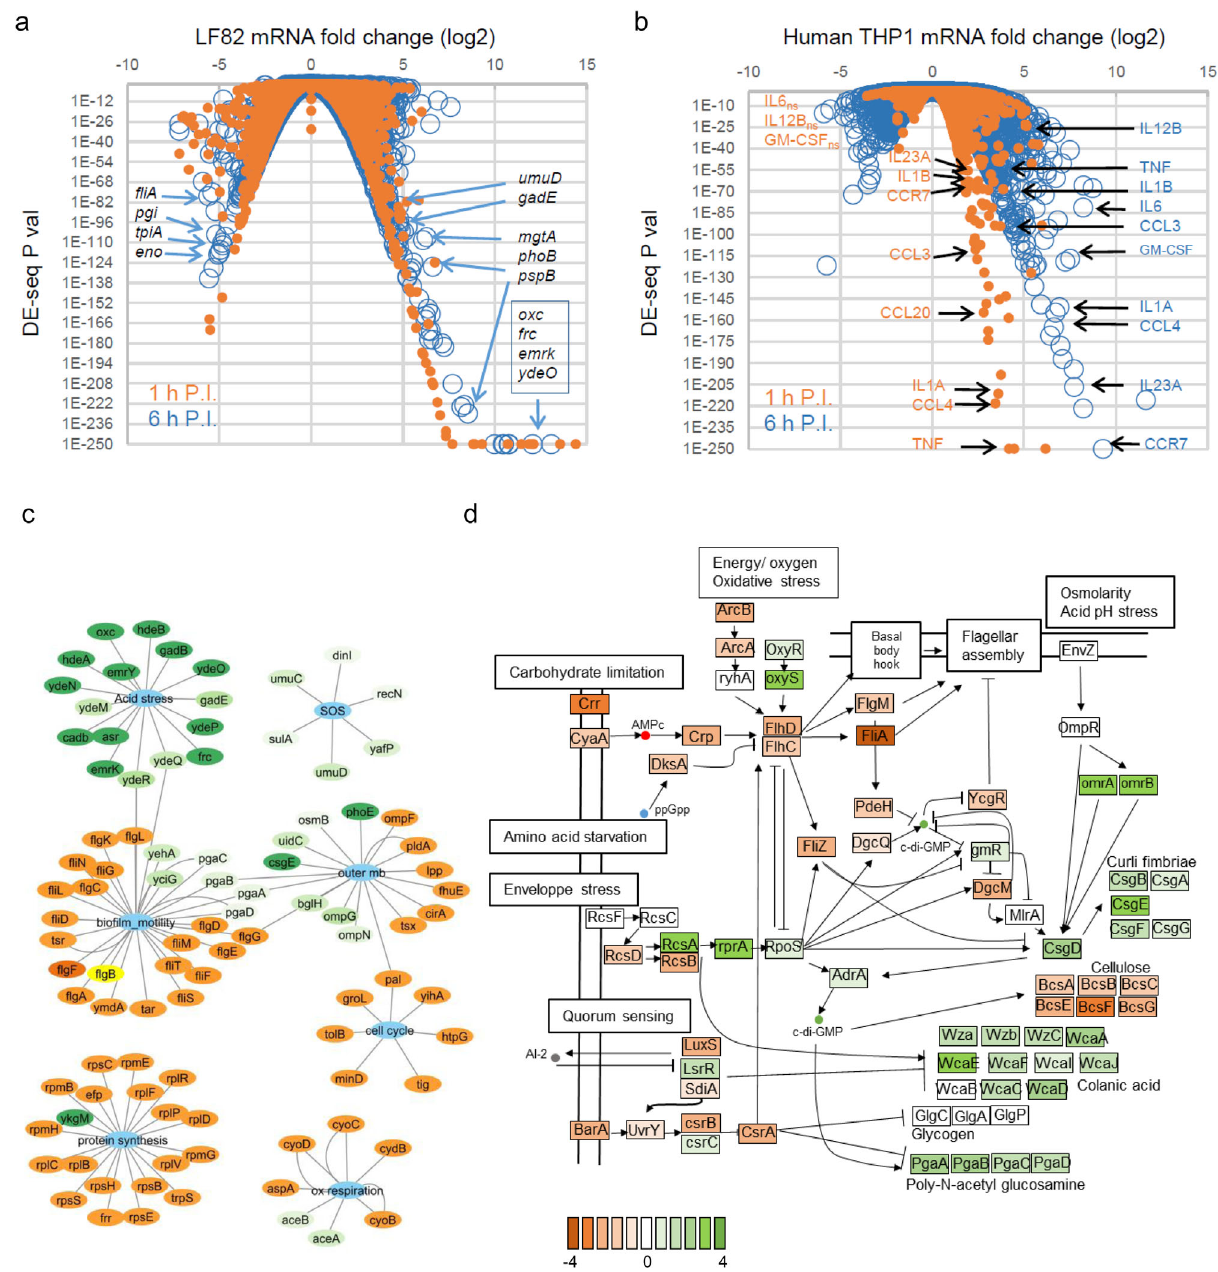
Fig. 2 Transcriptomic analysis of macrophage infection by LF82. a Expression data for the LF82 genes during infection of THP1 macrophages. Selected genes with highly signi fi cant expression changes at 6 h of P.I. are noted. b Expression data for the human genes from RNA-seq experiments at 1 and 6 h